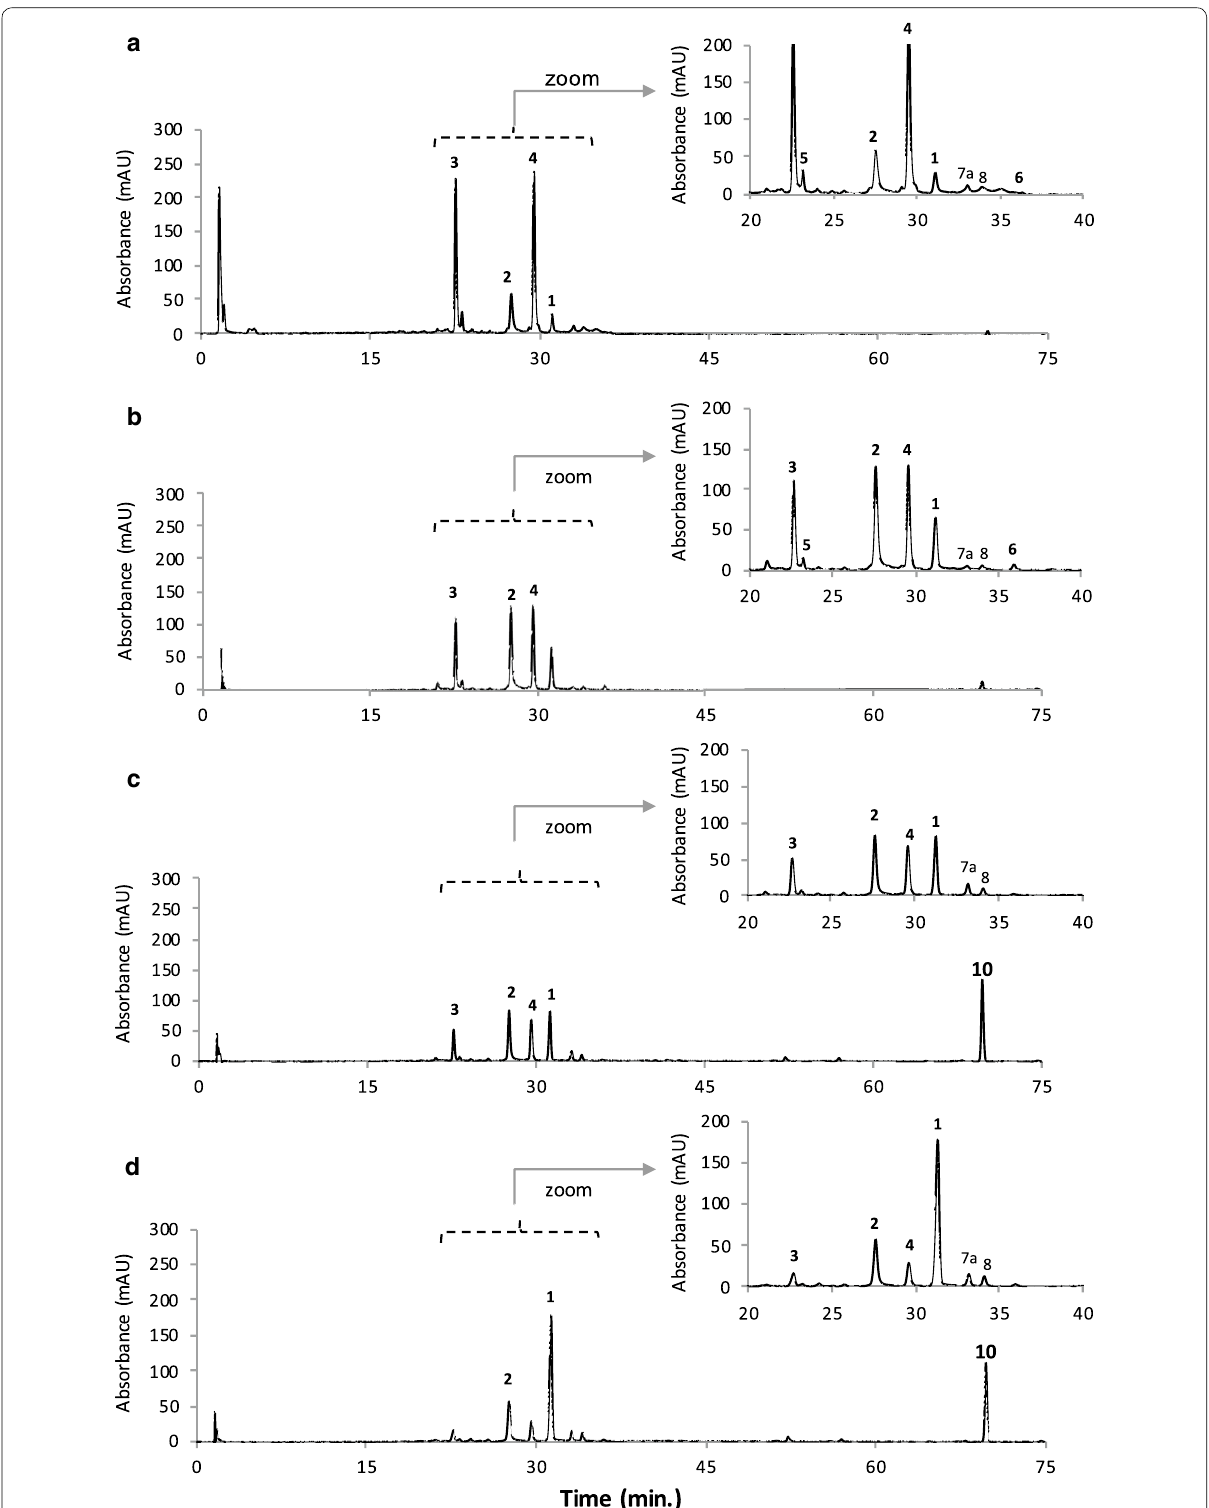
Fig. 3 HPLC-DAD chromatograms of intracellular extracts (IC) of F. oxysporum LCP531 mycelial cells grown on potato dextrose broth (PDB) and extracted with a 50% aqueous methanol (extract IC 8 shown in Fig. 1f), b then 50% aqueous ethanol (extract IC 9 ), c > 99.9% methanol (extract IC 10 ), and d MeOH:EtOH, 1:1, v/v (extract IC 11 ) as extraction solvents. See Fig. 2 for the